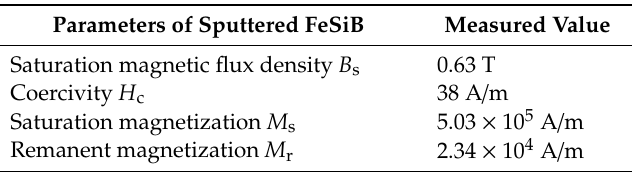
Table 1. Characteristic parameters of the sputtered FeSiB, obtained by superconducting quantum interference device (SQUID) measurement.